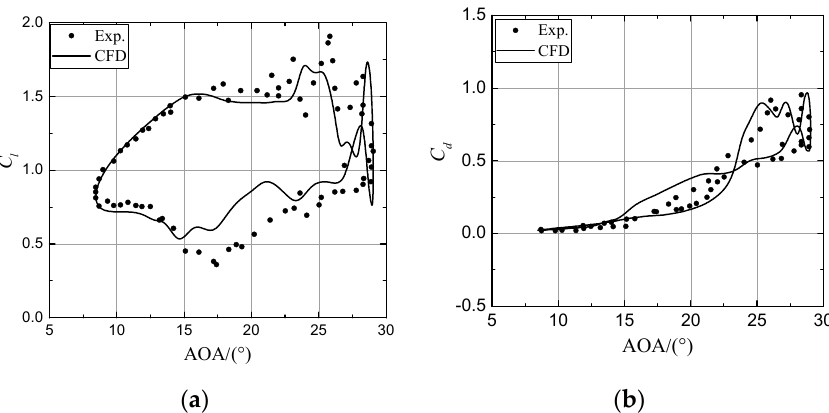
Figure 5. Hysteresis loops of the lift and drag coefficients in deep stall of the NREL S809 airfoil undergoing pitch oscillation. α = 20 ± 10 ◦ , k = 0.078, and Re = 1 × 10 6 . ( a ) C l ; ( b ) C d .